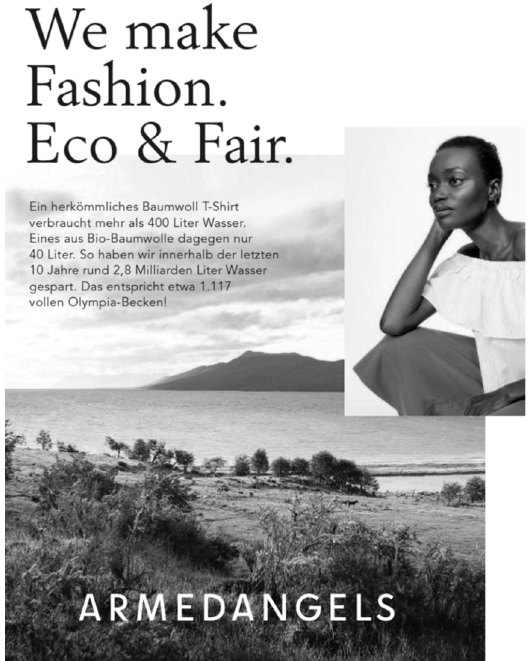
Figure 1. Armedangels advertisement (extract). Text of advertisement: “A conventional cotton t-shirt requires more than 400 L of water. An organic t-shirt, by comparison, only needs 40 L. That is how we have been able to save approximately 2.8 billion liters of water over the last 10 years. That corresponds to about 1117 Olympic swimming pools.” [2].